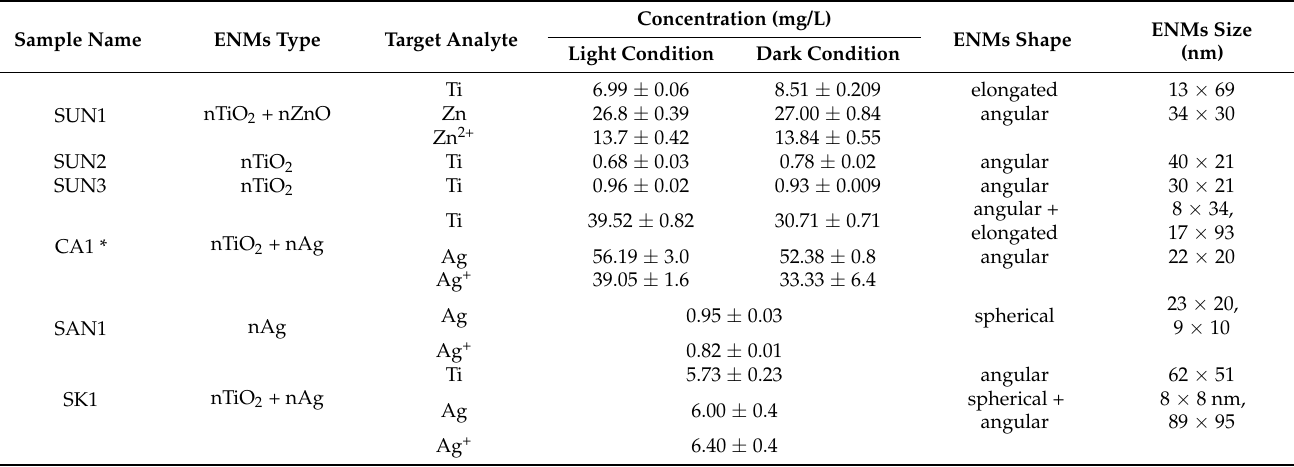
Table 2. The physicochemical properties of the PR-ENMs and ions examined for toxic effects as reported in [15]. The particle size is reported in terms of (width ×